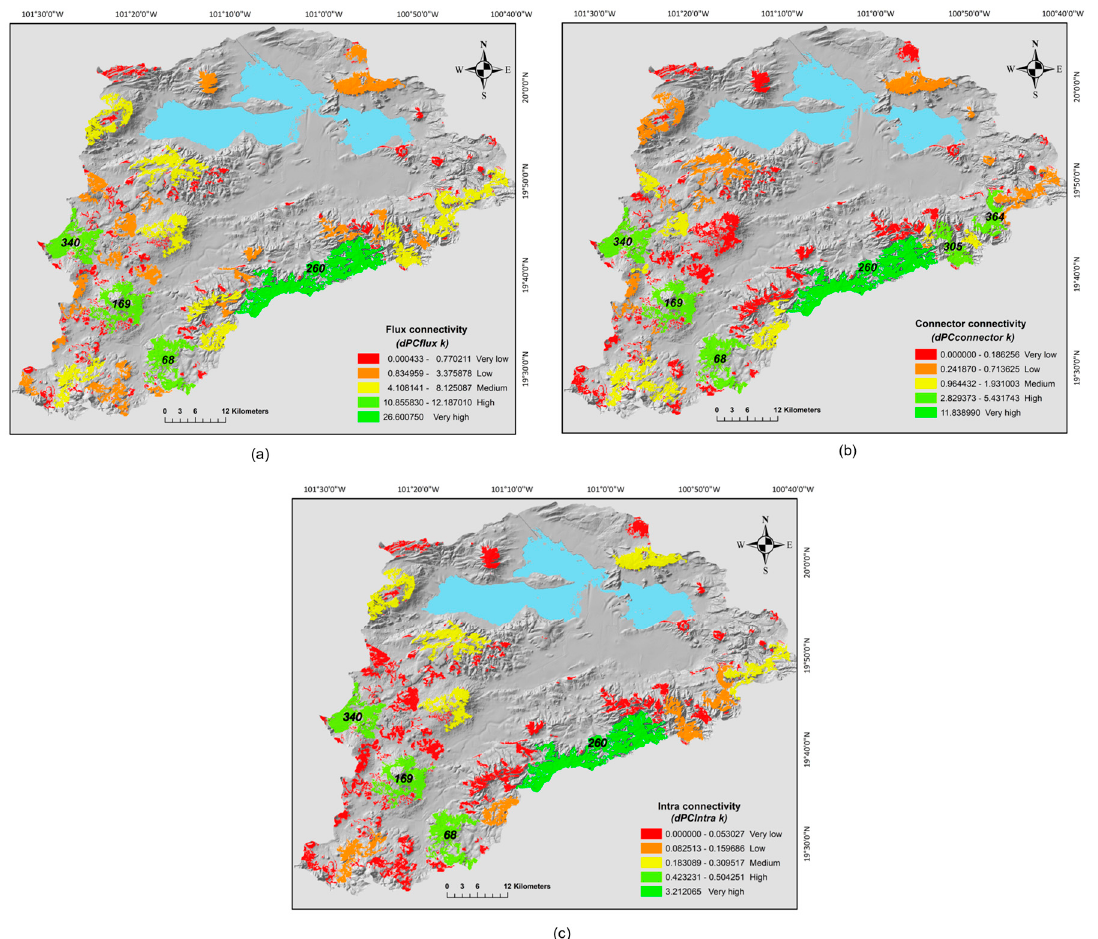
Figure 4. Different fractions of connectivity between oak forest fragments at the Cuitzeo basin; ( a ) flux connectivity ( dPCfluxk ), ( b ) connector connectivity ( dPCconnectork ) and ( c ) intrapatch connectivity ( dPCintrak ). Levels of importance for the three fractions of connectivity are shown in the figure, its classification was based on the Jenks optimization model. The id of the patches with the highest levels for the three fractions are exhibited in the maps.